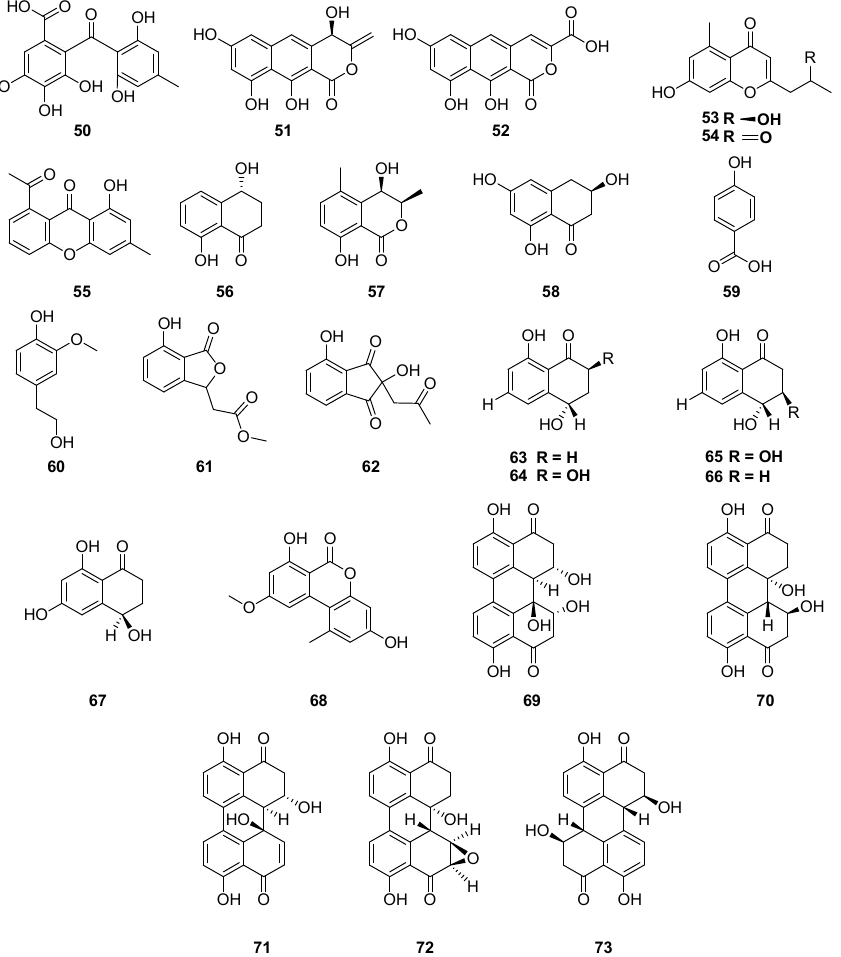
Figure 7. Compounds extracted from endophytic fungal strain Alternaria sp. isolated from medicinal plant M. o ffi